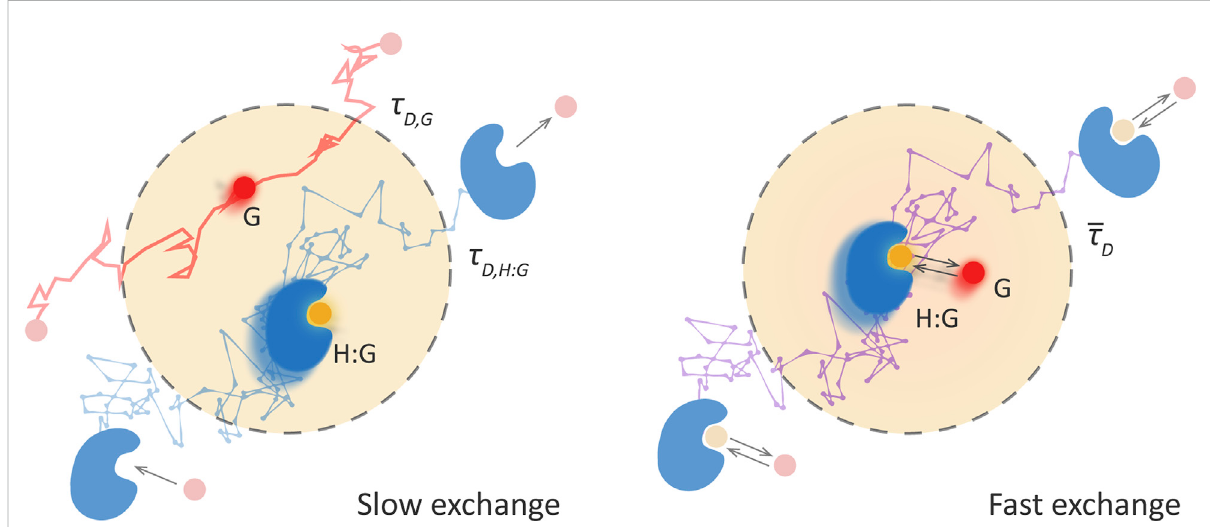
FIGURE 1 Thetwolimitingregimesforthestudyoftheassociationdynamicsofhost-guestsupramolecularsystemsbyFCS.Thedashedgreylineindicates the observation volume. Left panel: “ Slow exchange ”— the association dynamics are much slower than the diffusion time across the observation volume. The probability of an association or dissociation event during the observation is very low and the free guest, G, and the host-guest, H:G, are detected as separate species, each with its own diffusion time, τ D,G and τ D,H:G , respectively. Right panel: “ Fast exchange ”— the association dynamics are fast enough to occur many times during the transit and, therefore, only one mean diffusion time, (cid:1) τ D , is observed. Its value depends